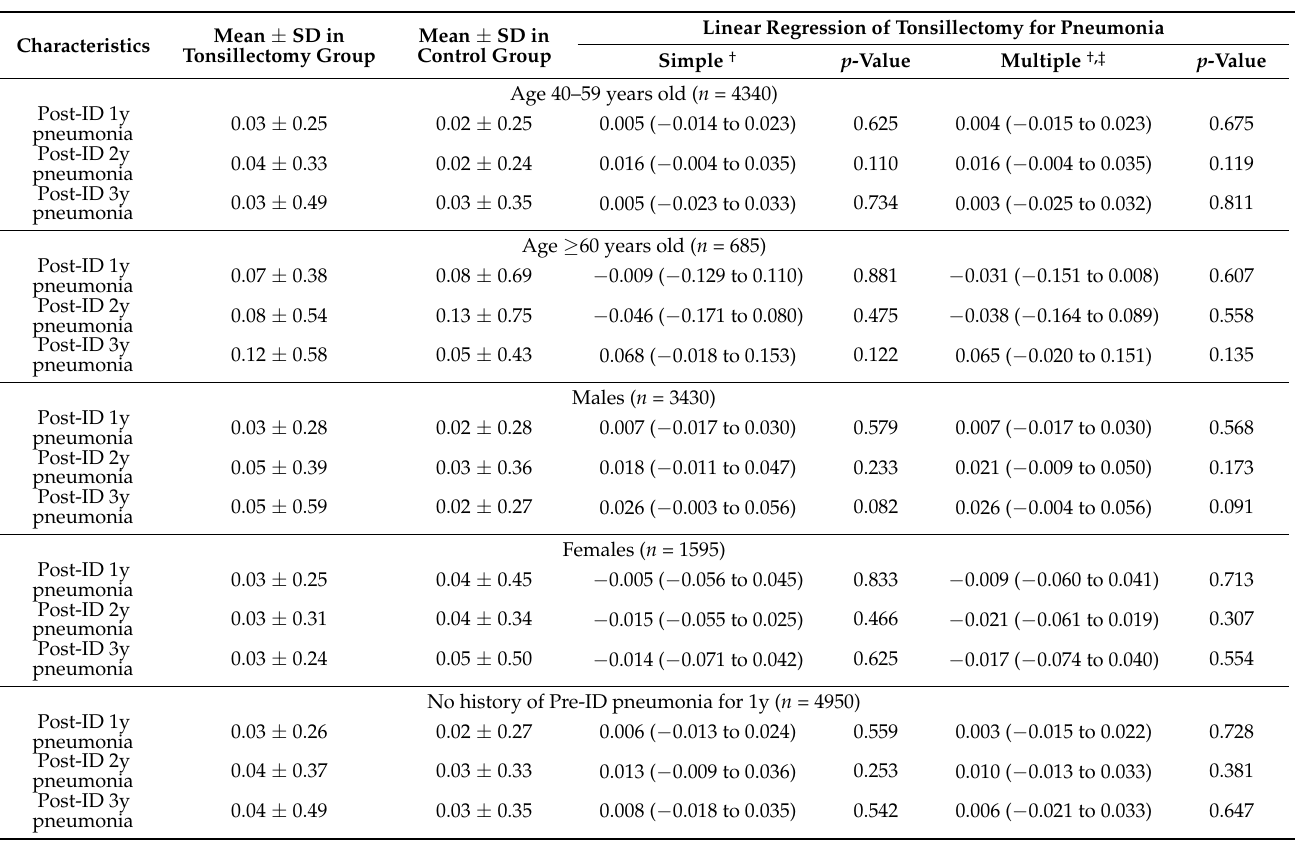
Table 3. Subgroup analyses of simple and multiple linear regression models (estimated value (95% confidence intervals)) for the post-index date of pneumonia (post-ID pneumonia) periods in tonsillectomy compared to the control group according to age, sex, and pre-index date of pneumonia for one year (pre-ID pneumonia for